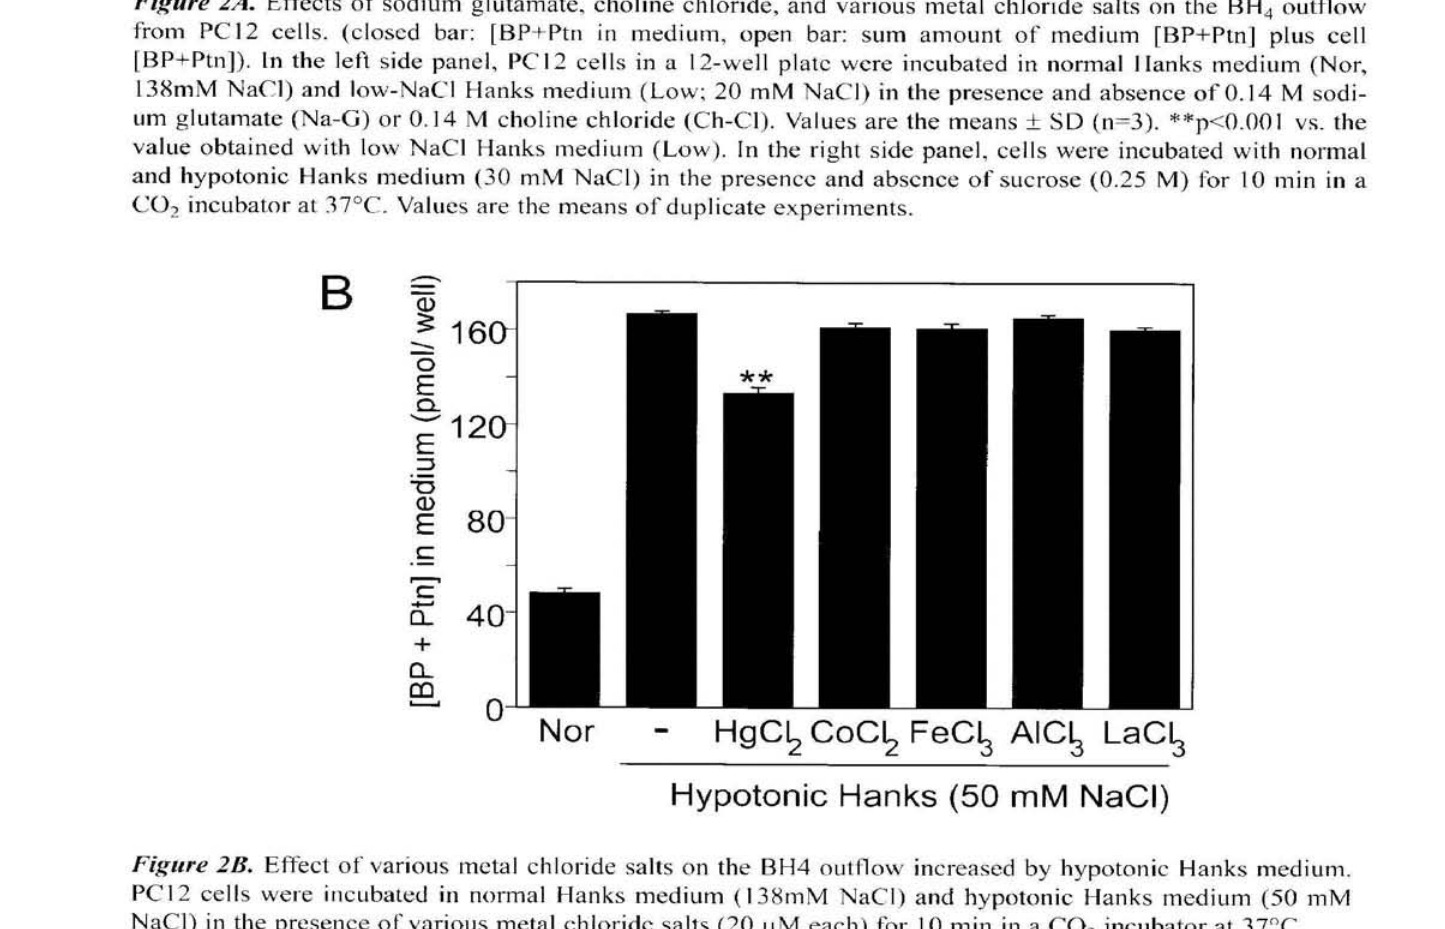
Pteridines/Vol. 16/No.